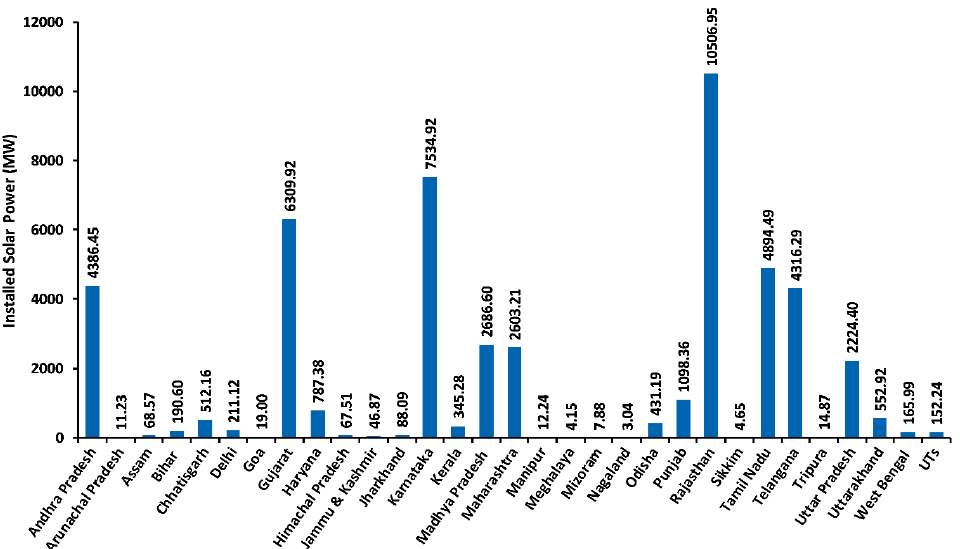
Figure 3 . State wise installed solar power capacity by 31 st January,